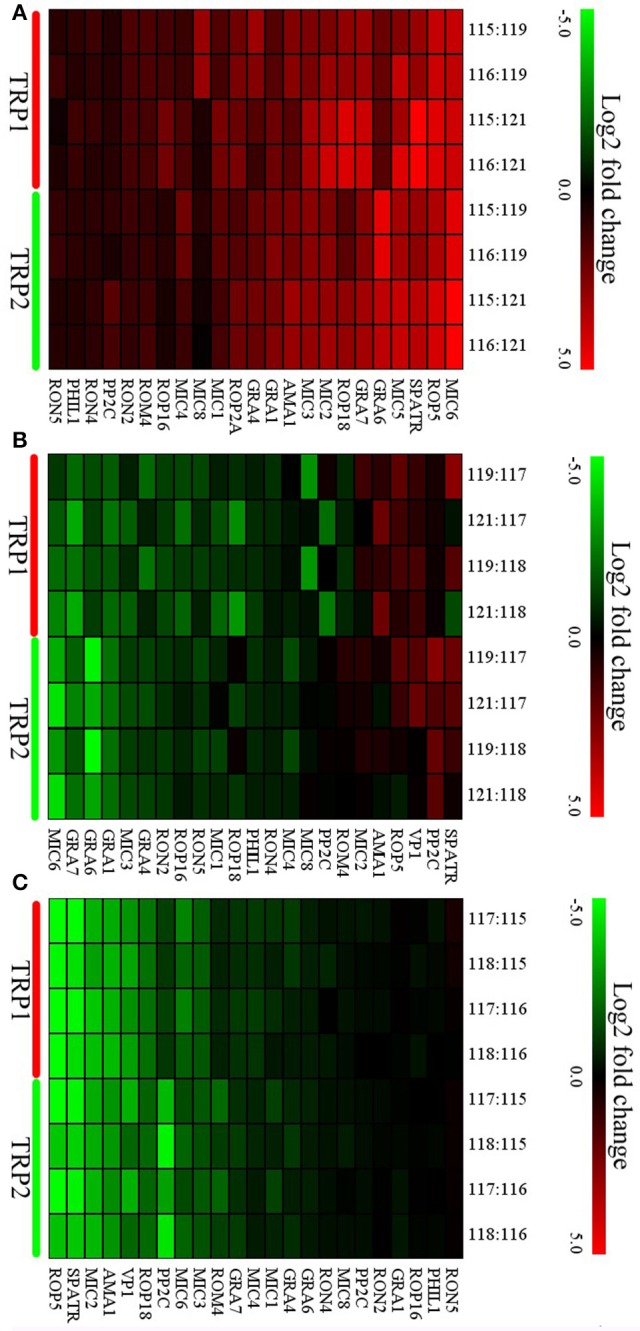
Expression profiles of differentially expressed (DE) virulence factors of O vs. T, T vs. C, and C vs. O. Expression values were log2-transformed and the expression levels were annotated with a gradient color scheme. The horizontal axis represents the logogram of virulence factors. The TRP1 and TRP2 in y-axis means biological replicate 1 and 2. (A–C) represent expression profiles of DE virulence factors for O vs. T, T vs. C, and C vs. O, respectively. O, oocysts; T, tachyzoites; C, bradyzoites-containing cysts.